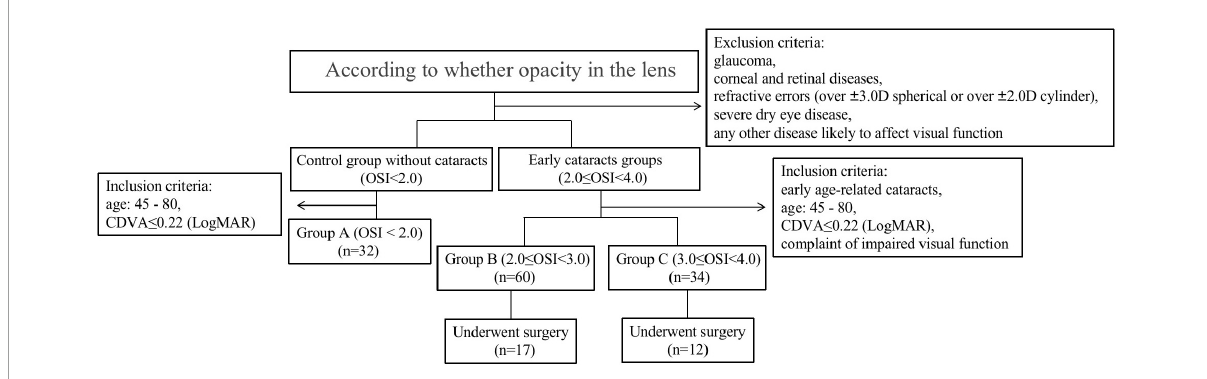
FIGURE1 The flow diagram of the overall the study design, including inclusion and exclusion criteria’s as well as participants distribution in each groups.